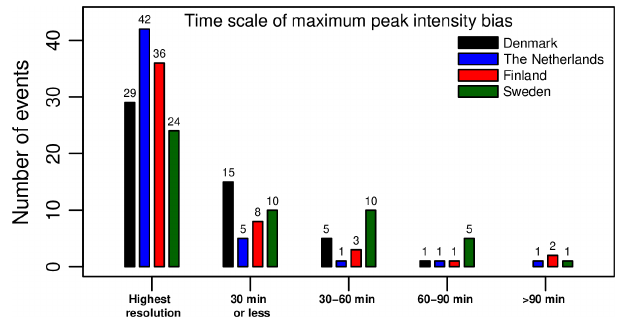
Figure 11. Aggregation timescale at which the maximum peak in- tensity bias between gauge and radar